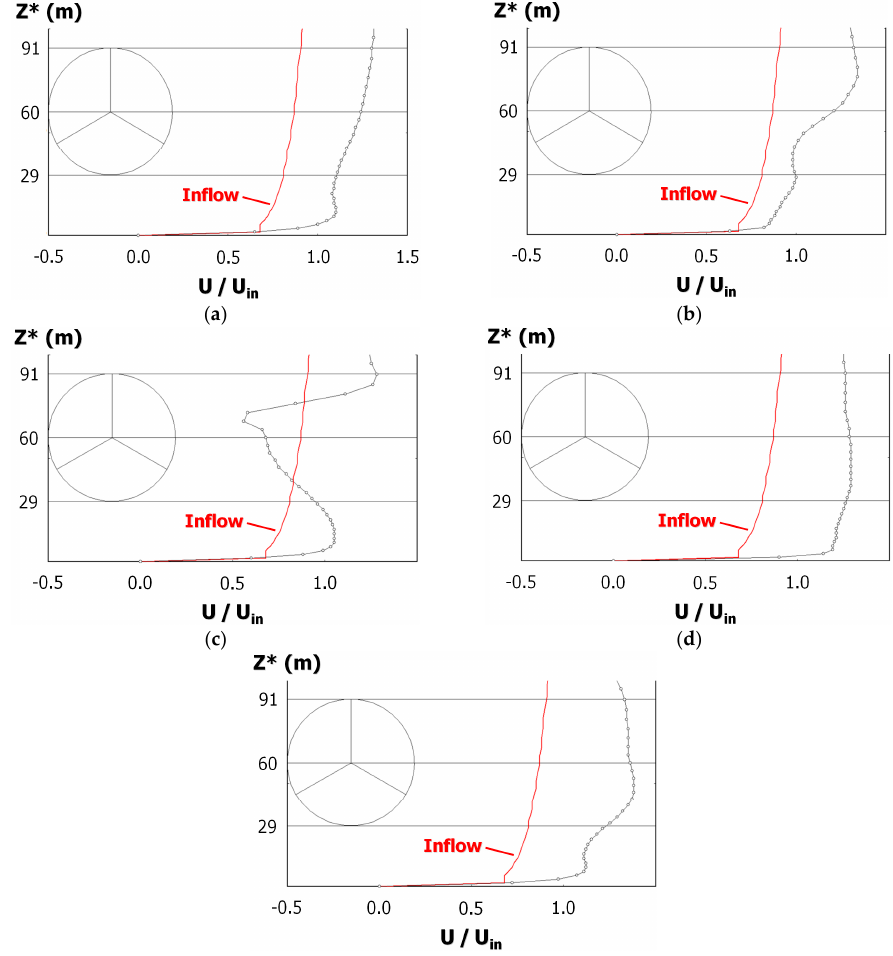
Figure 14. Temporal change in the vertical profile of the streamwise (x) wind velocity at the site of T7. The profiles in ( a – e ) correspond to the vertical cross-sectional views of the streamwise (x) wind velocity field shown in Figure 13a–e. ( a ) Non-dimensional time: 600.40, ( b ) Non-dimensional time: 600.56, ( c ) Non-dimensional time: 600.72; ( d ) Non-dimensional time: 600.88, ( e ) Non-dimensional time: 601.04. (z*(m): the height above the ground.)